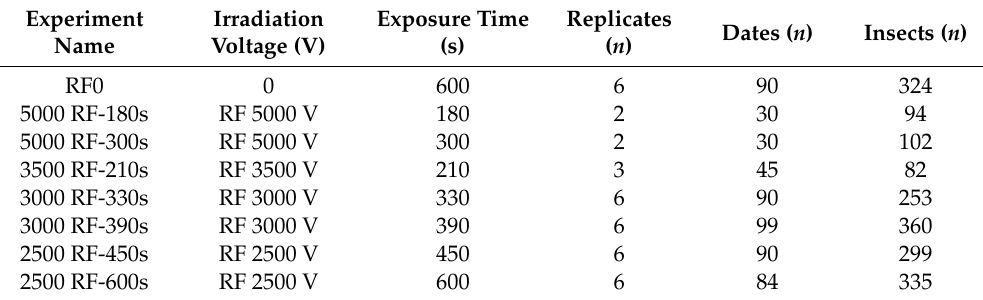
Table 1. Experimental layout of radio frequency time-voltage